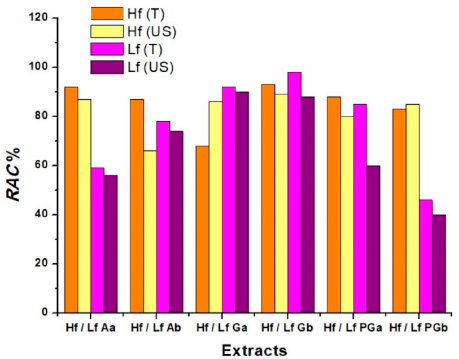
Figure 7. Histogram for the relative antioxidant capacity of each extract calculated using Equation (6).